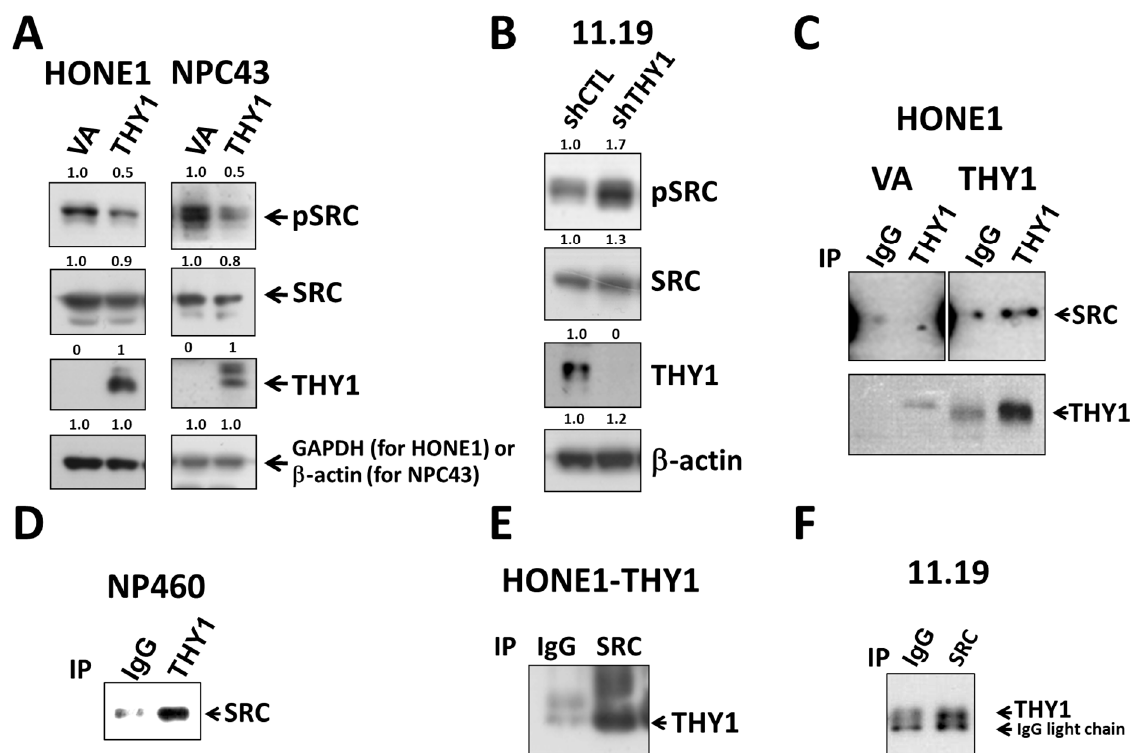
Figure 3. THY1 inhibits SRC activation and is physically associated with SRC in NPCs. Western blot analysis of pSRC (Y419), total SRC, and THY1 in ( A ) THY1-expressing NPC cells and ( B ) THY1- knockdown HK11.19 cells were shown. Co-IP analysis of SRC and THY1 using anti-THY1 was performed in ( C ) HONE1-VA, HONE1-THY1, and ( D ) NP460 cells. Using anti-SRC, co-IP analysis of SRC and THY1 was performed in ( E ) HONE1-THY1 and ( F ) HK11.19 cells.